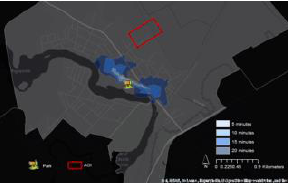
Figure 5. Accessibility of the study area to the existing park Moving forward, the next factor studied is the street